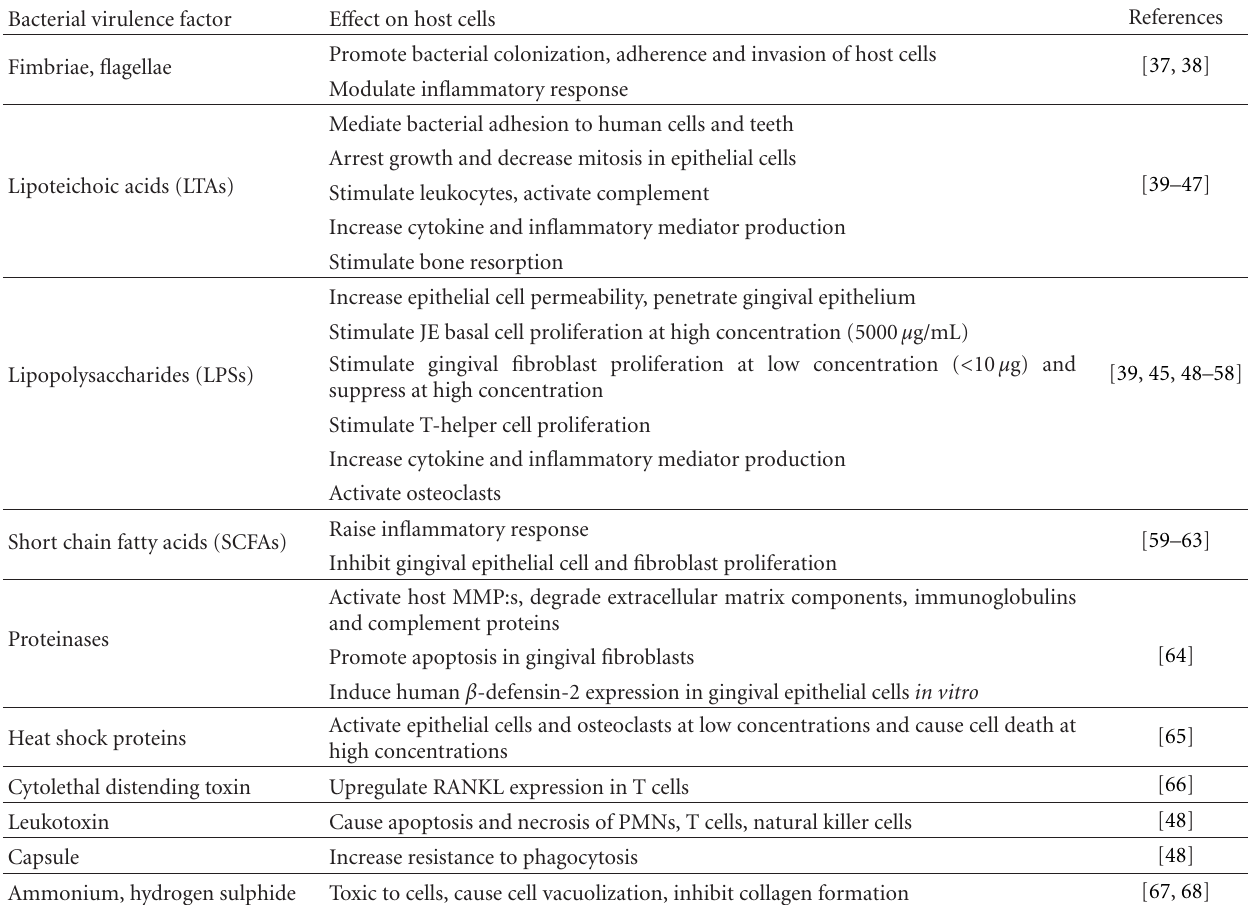
Table 1: Virulence factors of periodontopathogenic bacteria, and their e ff ects on host